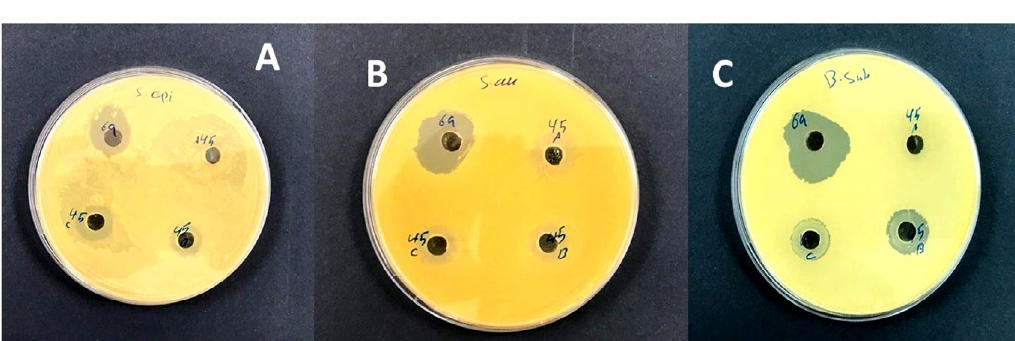
Fig. 3. A: Streptomyces lavenduligriseus (AC 45) was recorded a moderate effect against Staphylococcus epidermidis while Streptomyces sp.(AC 69) showed a good effect. B: isolate of Streptomyces sp. (AC 69) showed a strong effect against Staphylococcus aureus while isolate S. lavenduligriseus (AC 45) showed a moderate effect. C: the same result in B but in the presence of Bacillus subtilis .